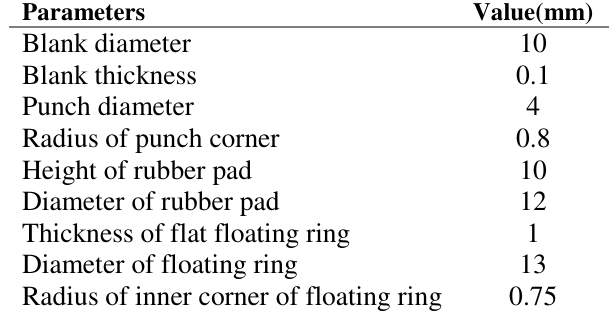
Geometrical parameters of flexible micro deep drawing